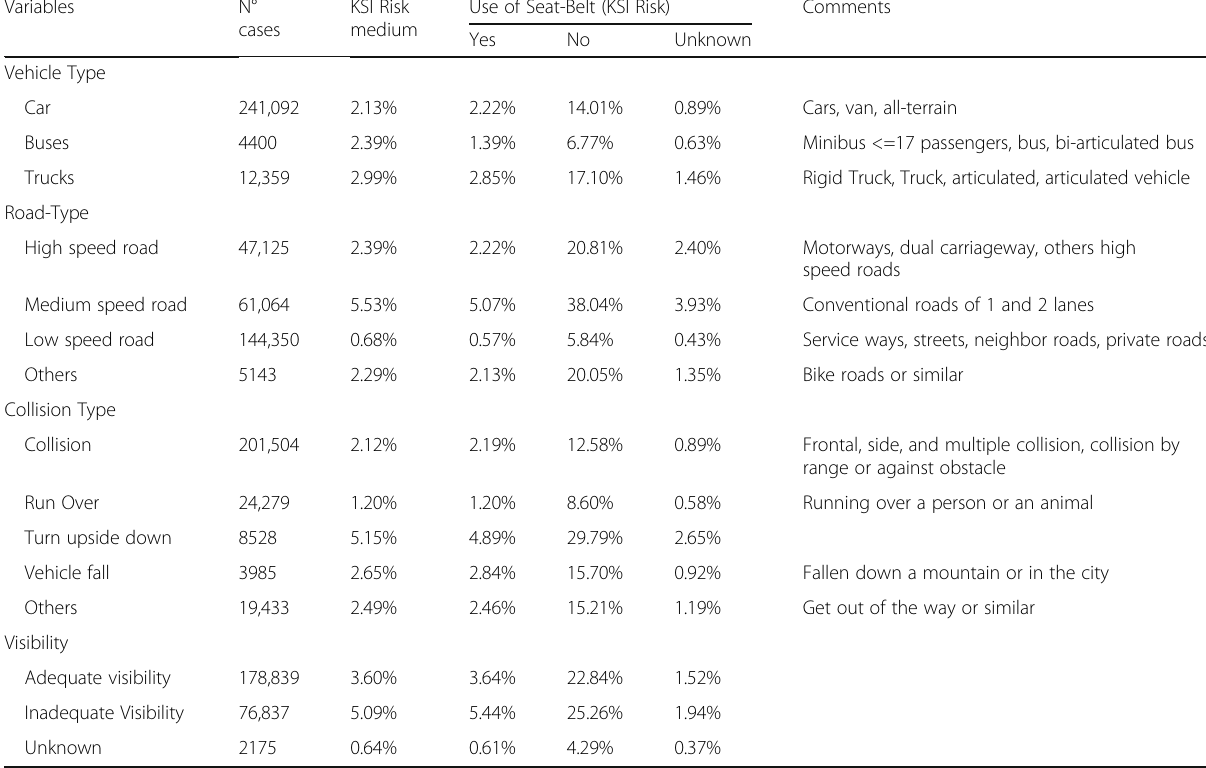
Table 5 Probabilities of suffering a serious injury, depending on the use of seat belt and the different variables of the conditioning factor. Processed by the Authors